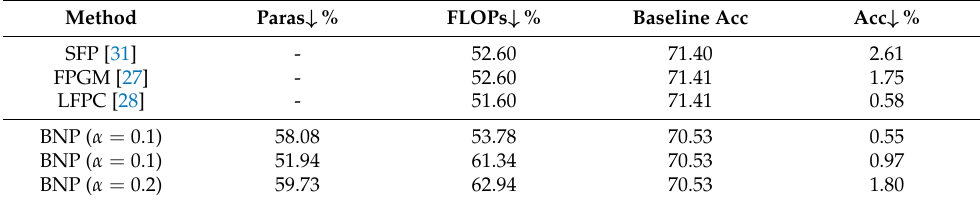
Table 4. Network pruning results of ResNet-56 on CIFAR-100.